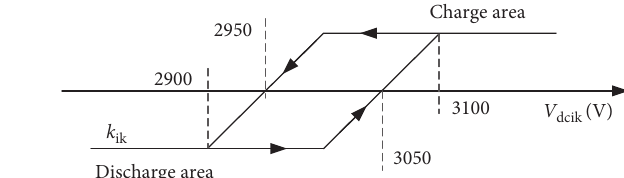
Figure 8: Hysteresis control strategy for charge and discharge